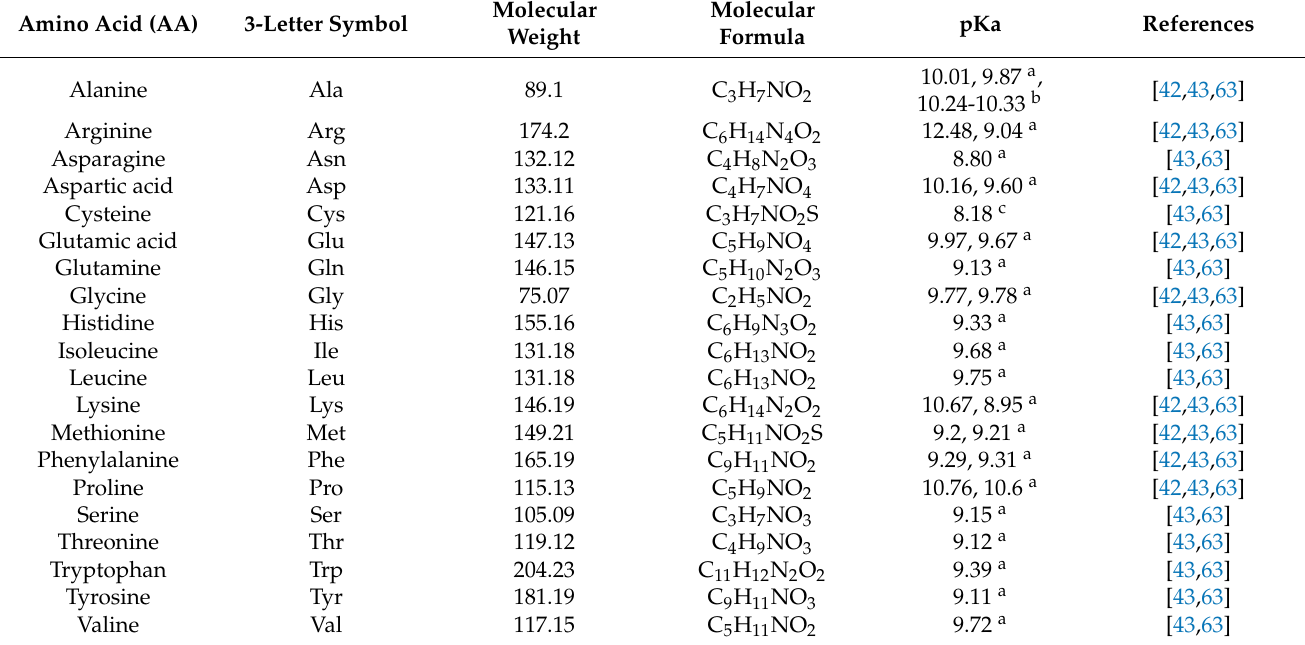
Table 5. List of basic 20 amino